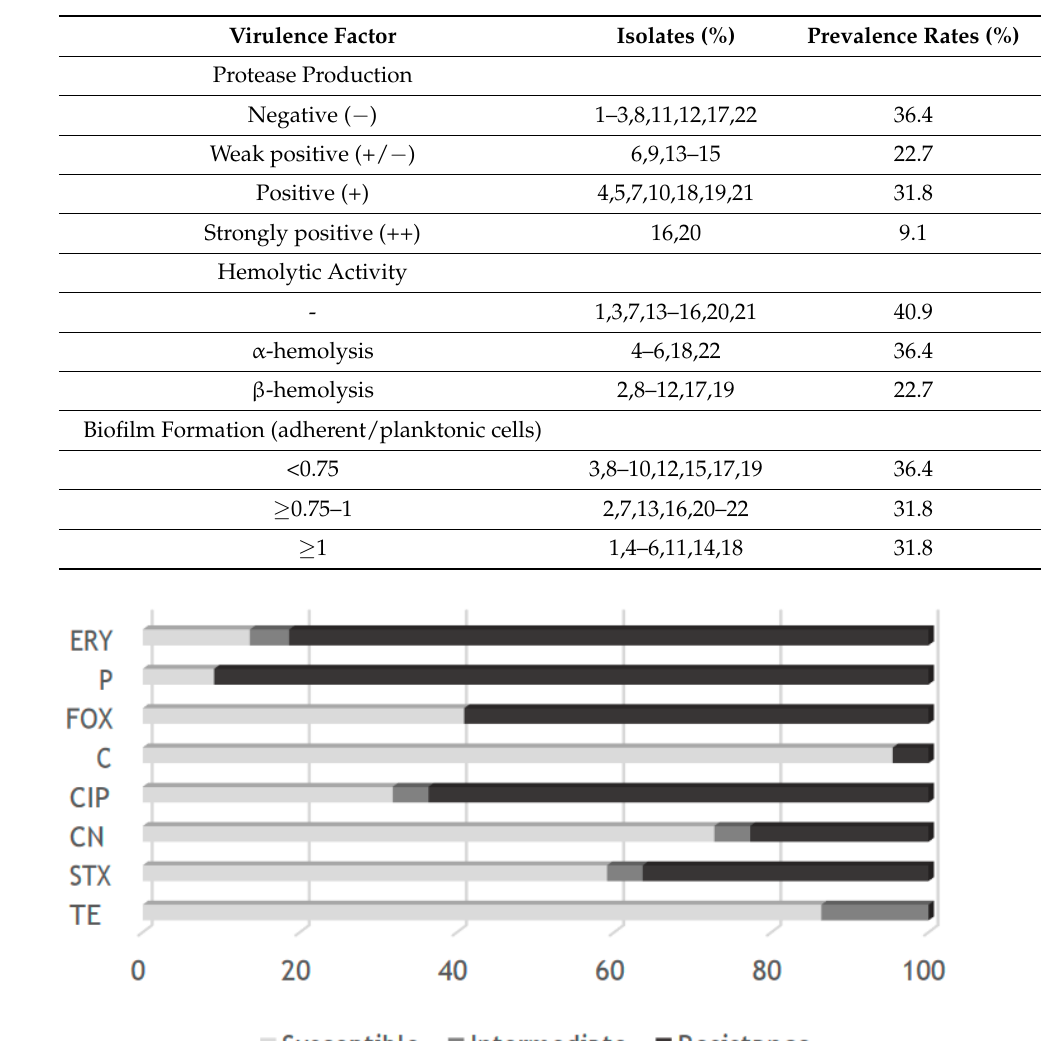
Figure 1. Antibiotic susceptibility profile of Staphylococcus isolates; TE-tetracycline;